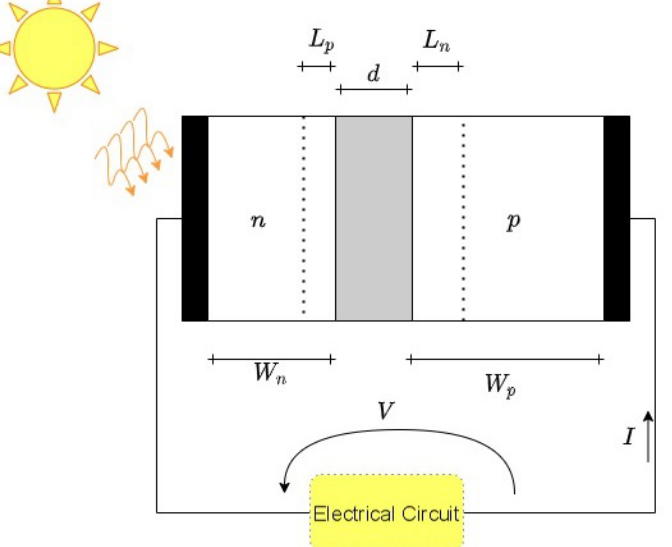
Figure 3. Diagram of a p-n junction solar